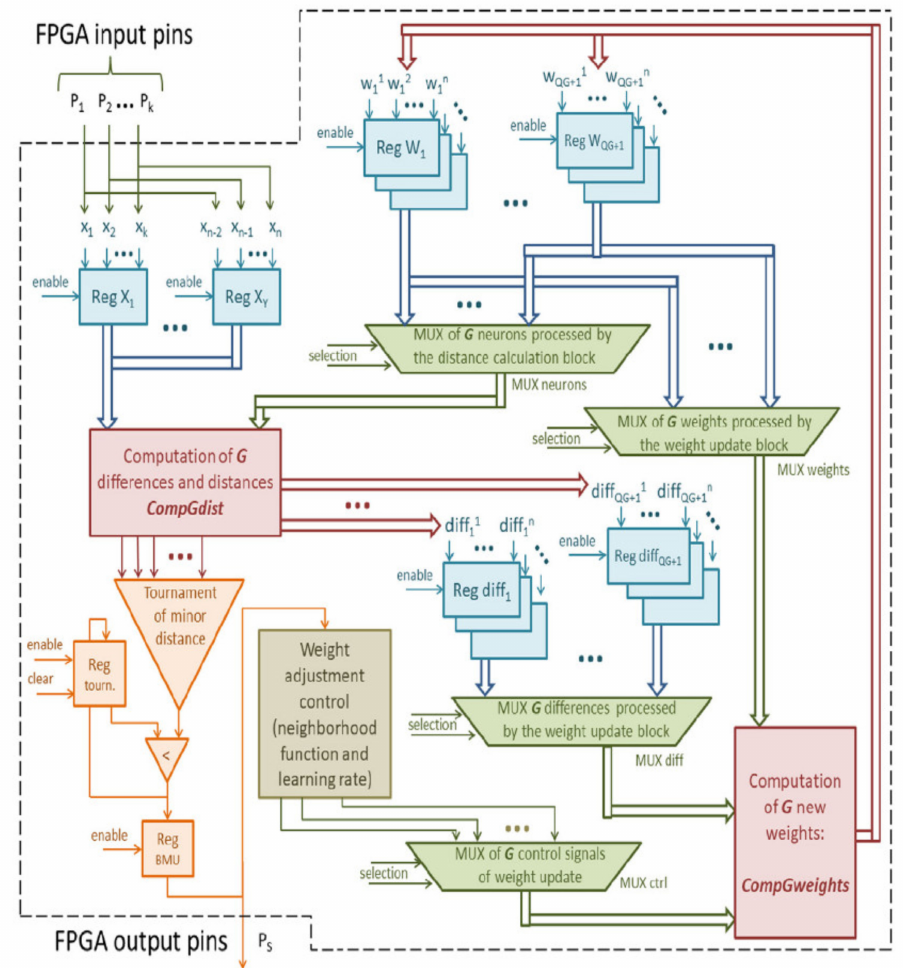
Figure 16. Schematic of Self-Organizing Maps [52] (Reprinted with permission from ref. [52]. Copy- right 2021